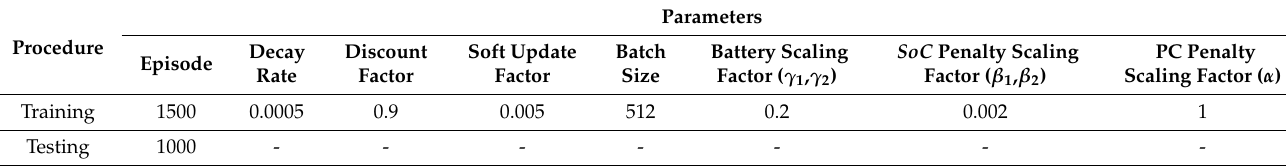
Table 3. The parameters of the training and testing procedure.